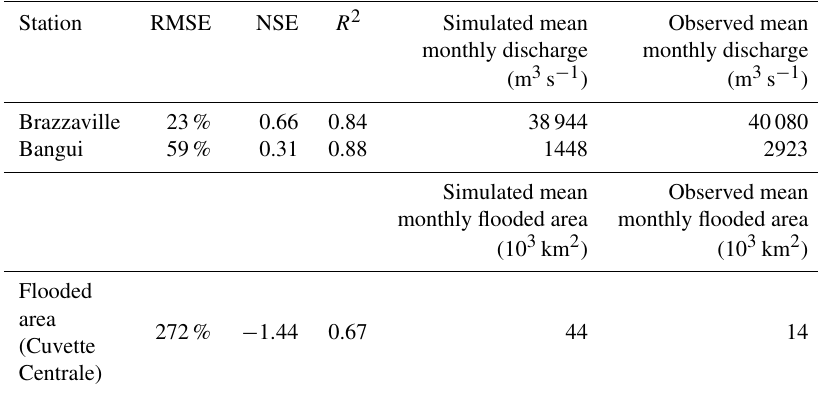
Table 2. Performance statistics for the modelled versus observed seasonality of discharge at Brazzaville and Bangui, as well as flooded area in Cuvette Centrale. Observed flooded area is from GIEMS (Papa et al., 2010; Becker et al.,